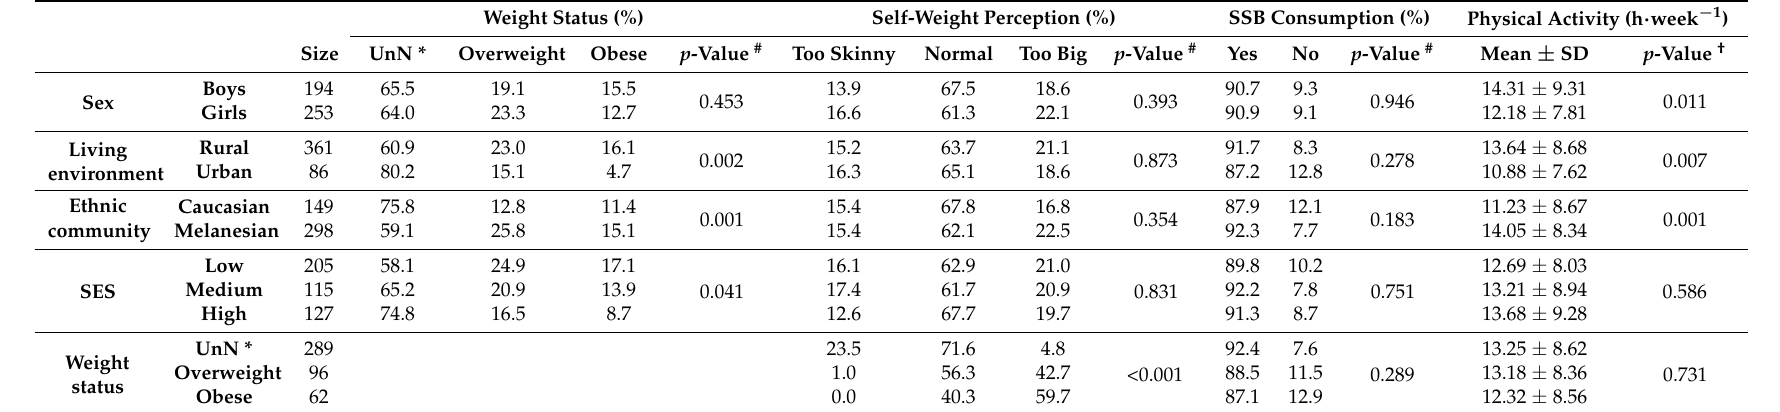
Table 1. Population: proportions of weight status, weight perception, SSB consumption (yes or no) and physical activity according to sex, living environment, ethnic community, socioeconomic status (SES) and weight status ( n = 447).